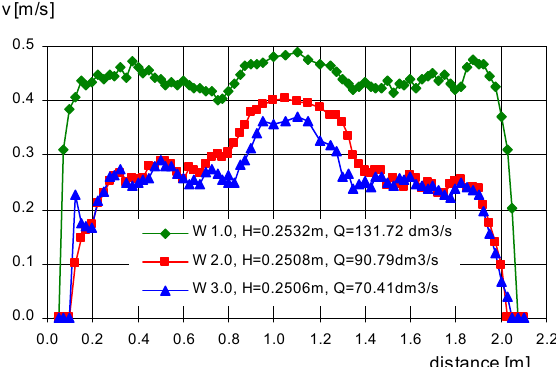
Figure 8. Distribution of average velocity in verticals in W 1.0, W 2.0 and W 3.0 variants with similar flow depths in the channel.